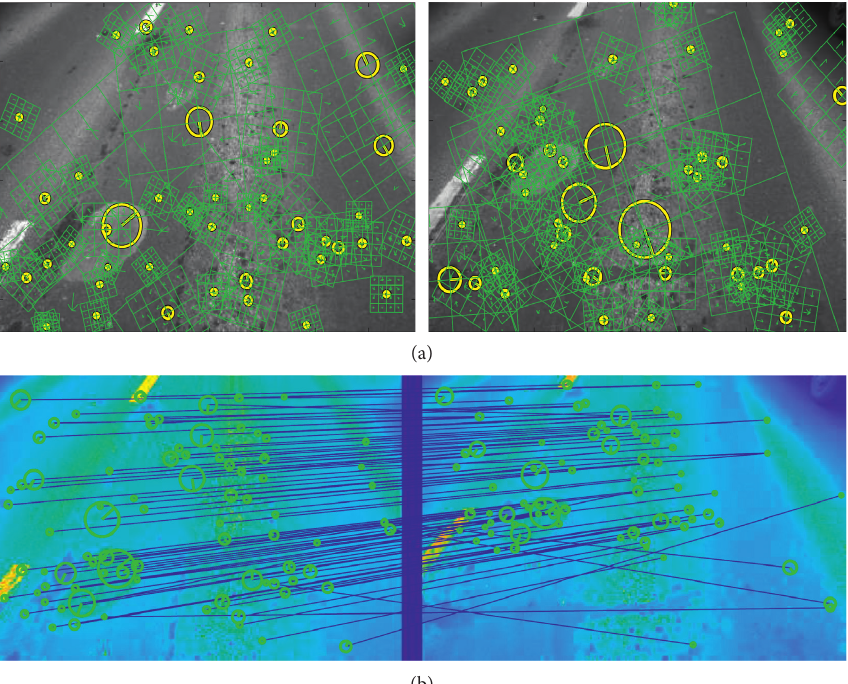
Figure 6: SIFTfeatures matching. (a) The gradient direction of extracted features of two images. (b) Links between matched features of two images.